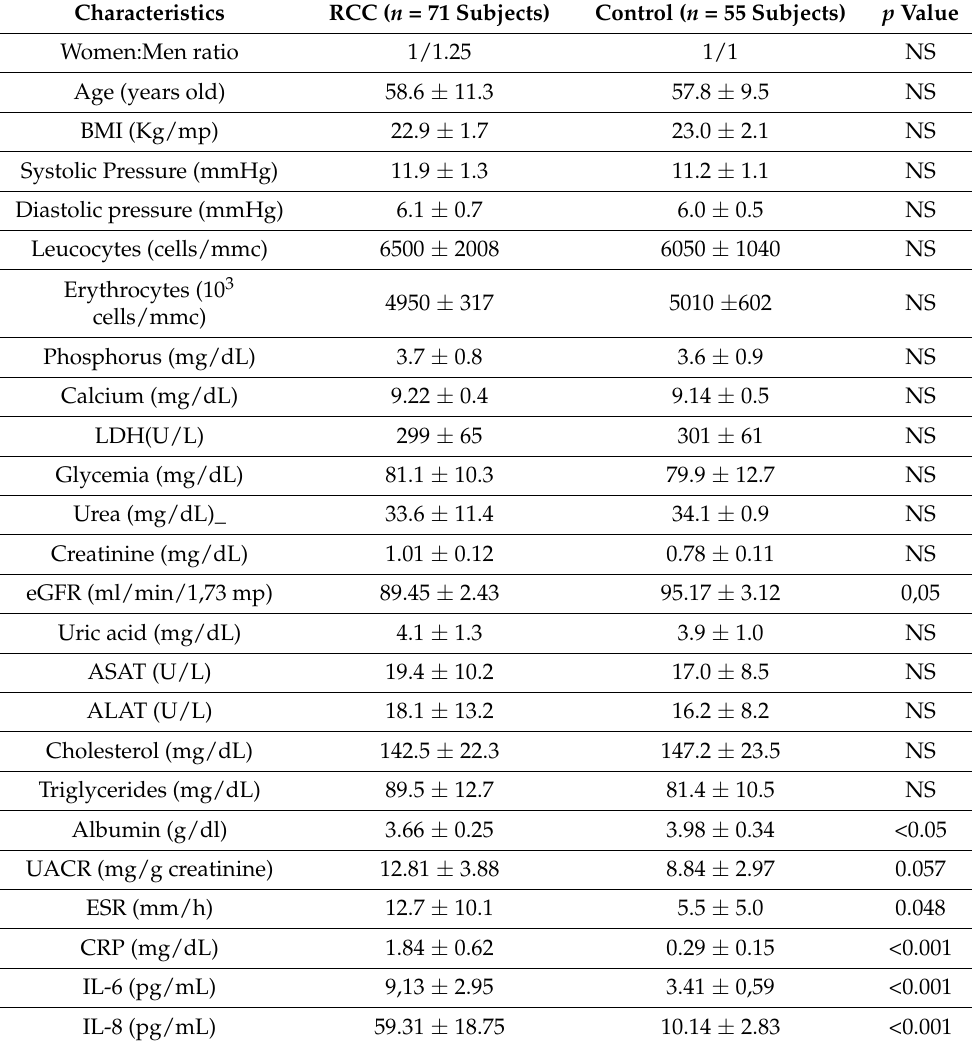
Table 8. Patients’ characteristics in the studied